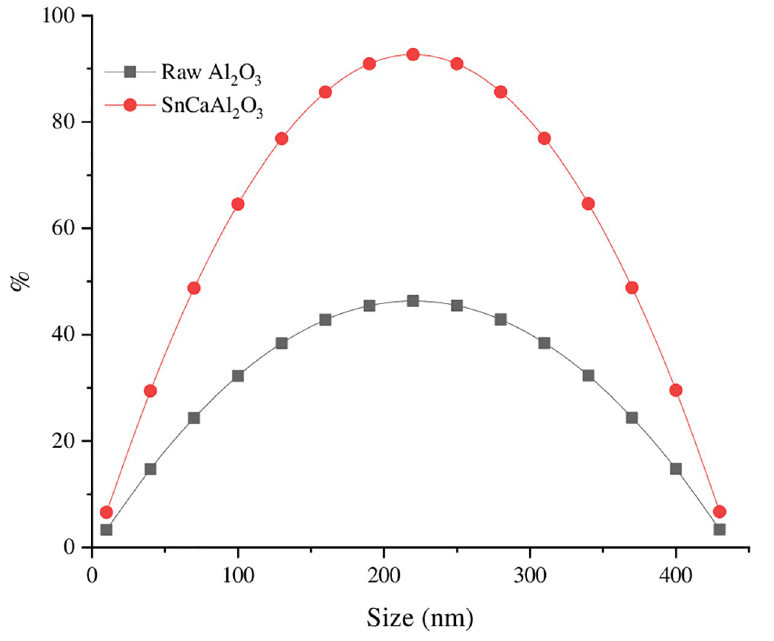
Fig 7. Particle size distribution of Al 2 O 3 and SnCaAl 2 O 3 NPs.